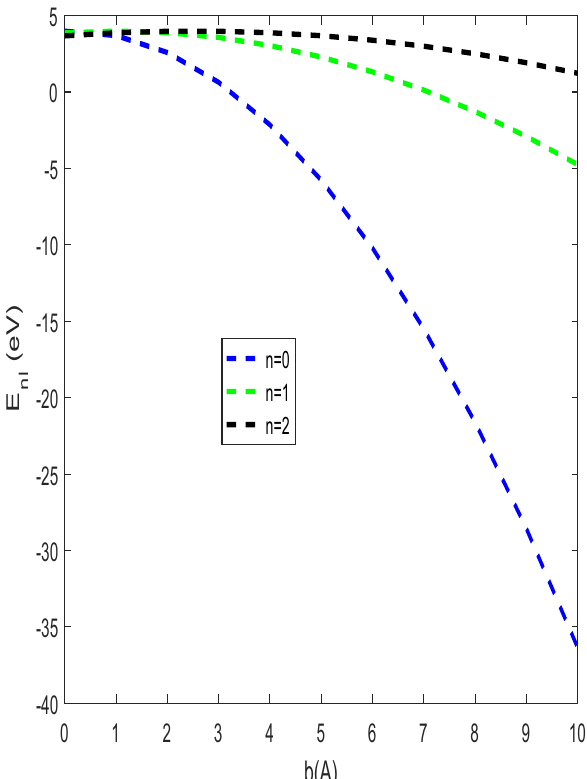
Figure 4. Energy E n , ℓ against the b with µ = (cid:31) = ℓ = 1, b h = 0.001 Å, C h = 0.95, r e = 0.5 Å and D e = 10